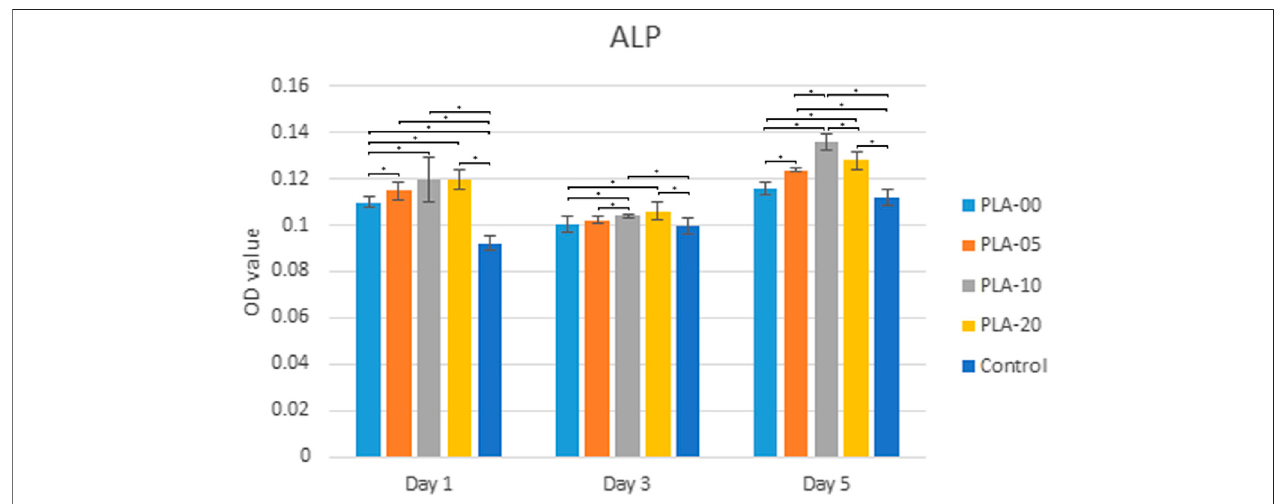
FIGURE 7 | ALPase activity. PLA-10 and PLA-20 demonstrated signi fi cant ALPase performance (* p < 0.05) at days 1, 3, and